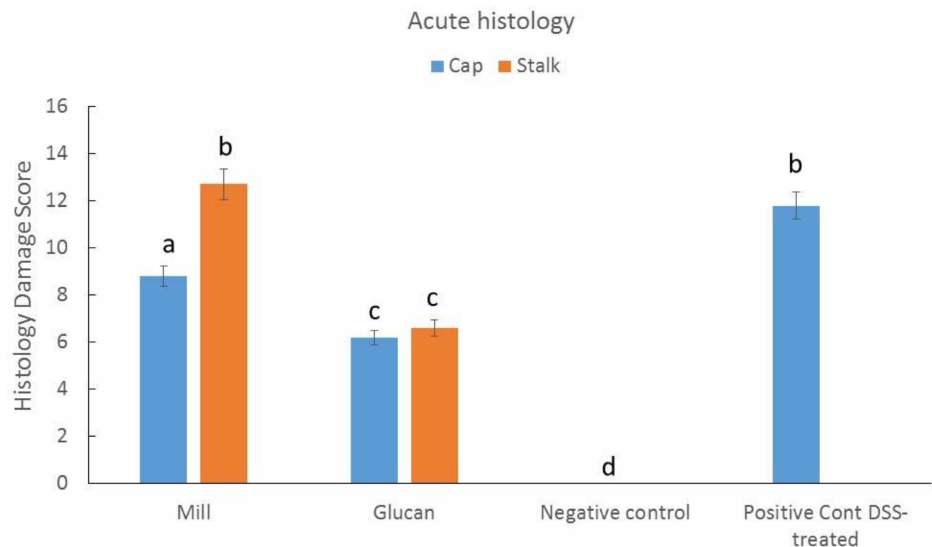
Figure 3. Effect of mill and isolated glucans from caps and stalks of P. eryngii mushrooms (1 mg glucan/kg mice BW) on histologic damage score in dextran sulfate sodium (DSS)-induced colitis. DSS was administrated for 7 days and mill and glucan extract treatment started with DSS treatment and continued until day 16 when all mice were sacrificed and tissue samples were taken for analysis. Data represent mean ± SD of six mice per group. Different letters indicate significantly different values at p <